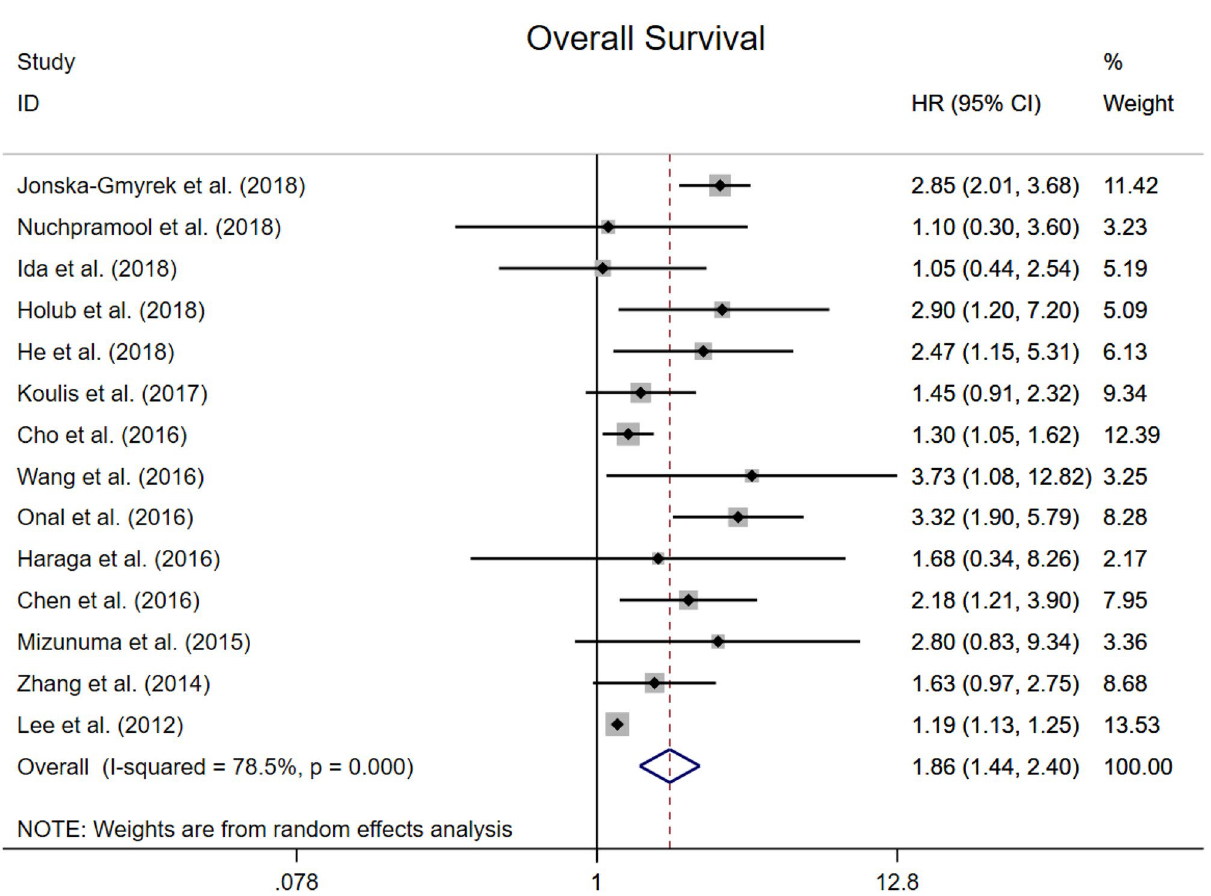
Figure 2. Forest plots showing hazard ratio for overall survival in all studies for neutrophil-to-lymphocyte